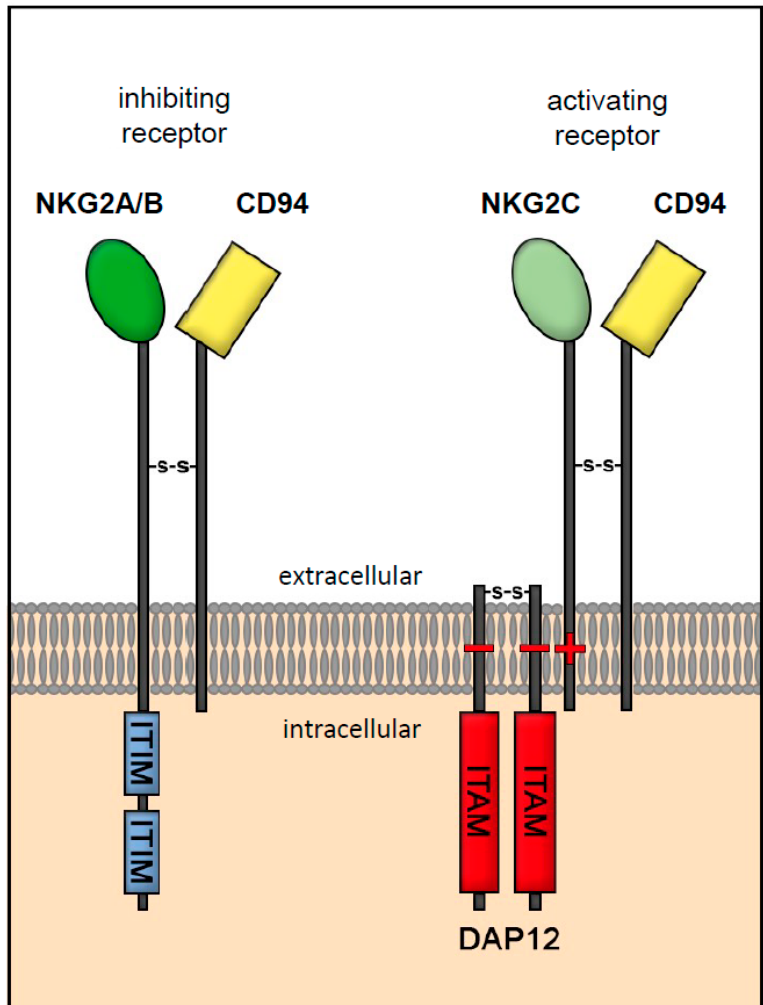
Figure 1. Receptor interaction of HLA-E with NKG2A, -B / CD94 and NKG2C / CD94. HLA-E binds to the inhibiting receptors NKG2A, -B and activating receptor NKG2C, belonging to the killer cell lectin-like receptor C1 (KLRC1) family, expressed on NK cells. The NKG2A and -B receptors mediate an inhibitory signal to the NK cell via immunoreceptor tyrosine-based inhibition motifs (ITIMs) [51]. The activating receptor NKG2C does not possess an intracellular immunoreceptor tyrosine-based activating motif (ITAM), but contains a positively charged transmembrane domain and dimerize with DNAX activation protein 12 (DAP-12), which has an ITAM in its cytoplasmic domain and transmits an activating signal to the cell